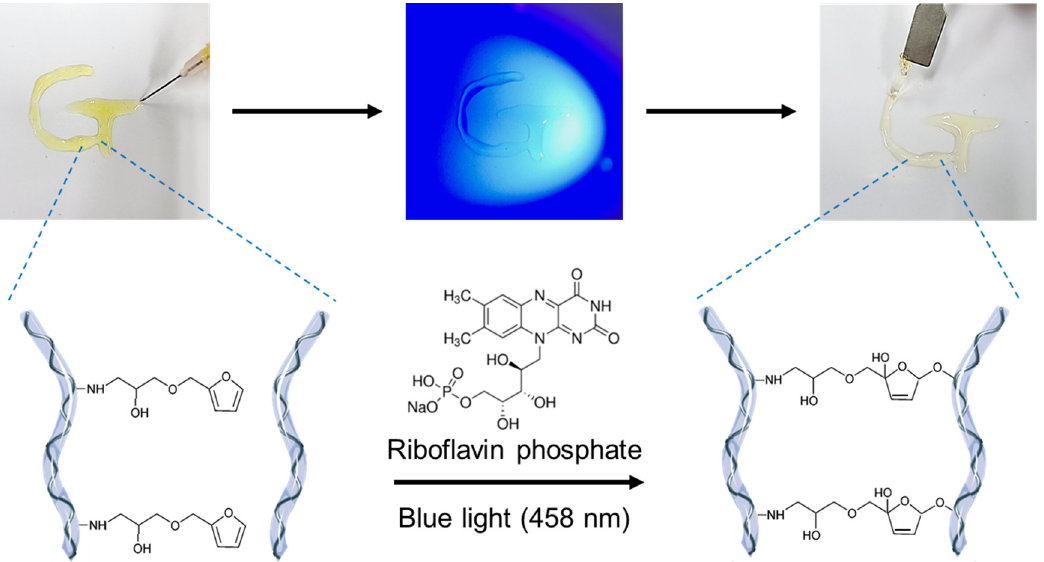
Figure 2. Photocrosslinking mechanism of furfuryl-gelatin hydrogel by blue light (458 nm) irradiation using riboflavin phosphate.